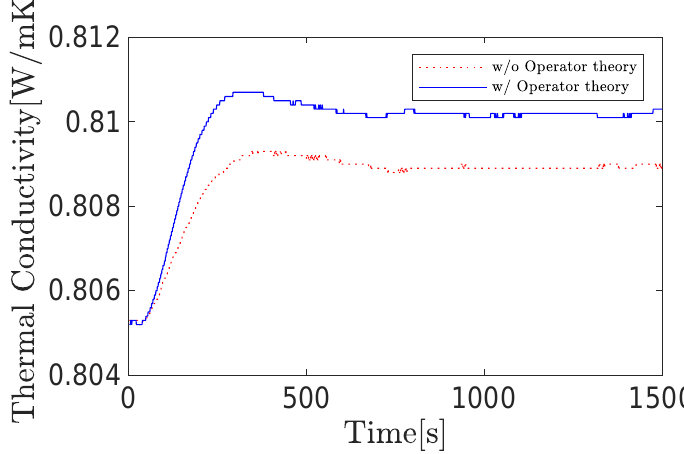
Figure 13. Time variation of thermal